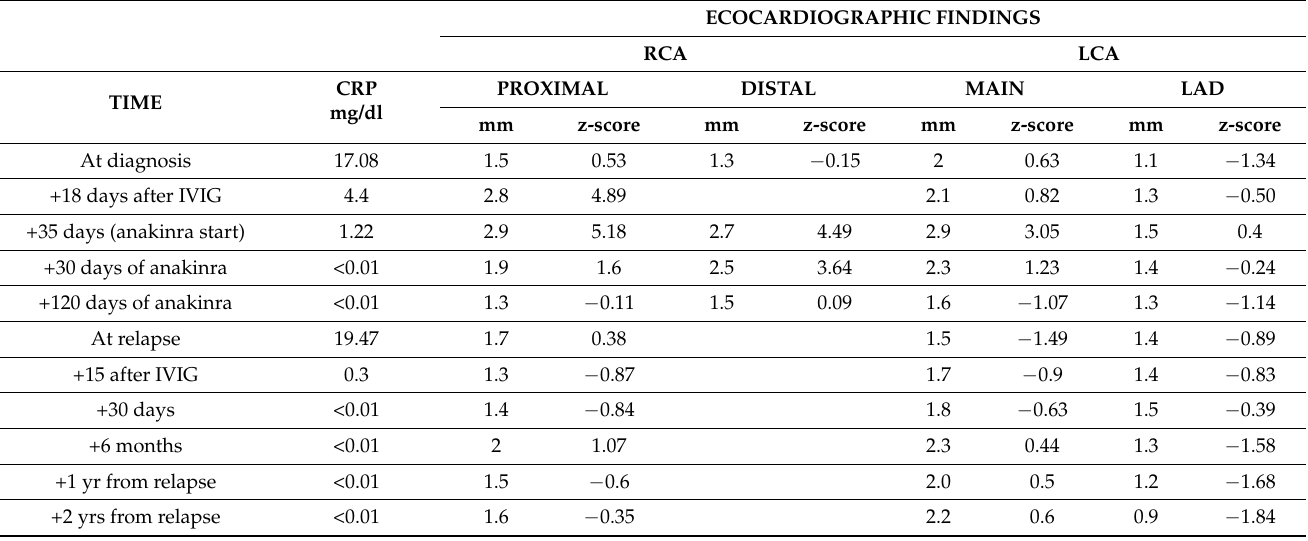
Table 1. Time course of CRP levels, coronary arteries diameters and z-score. ECOCARDIOGRAPHIC